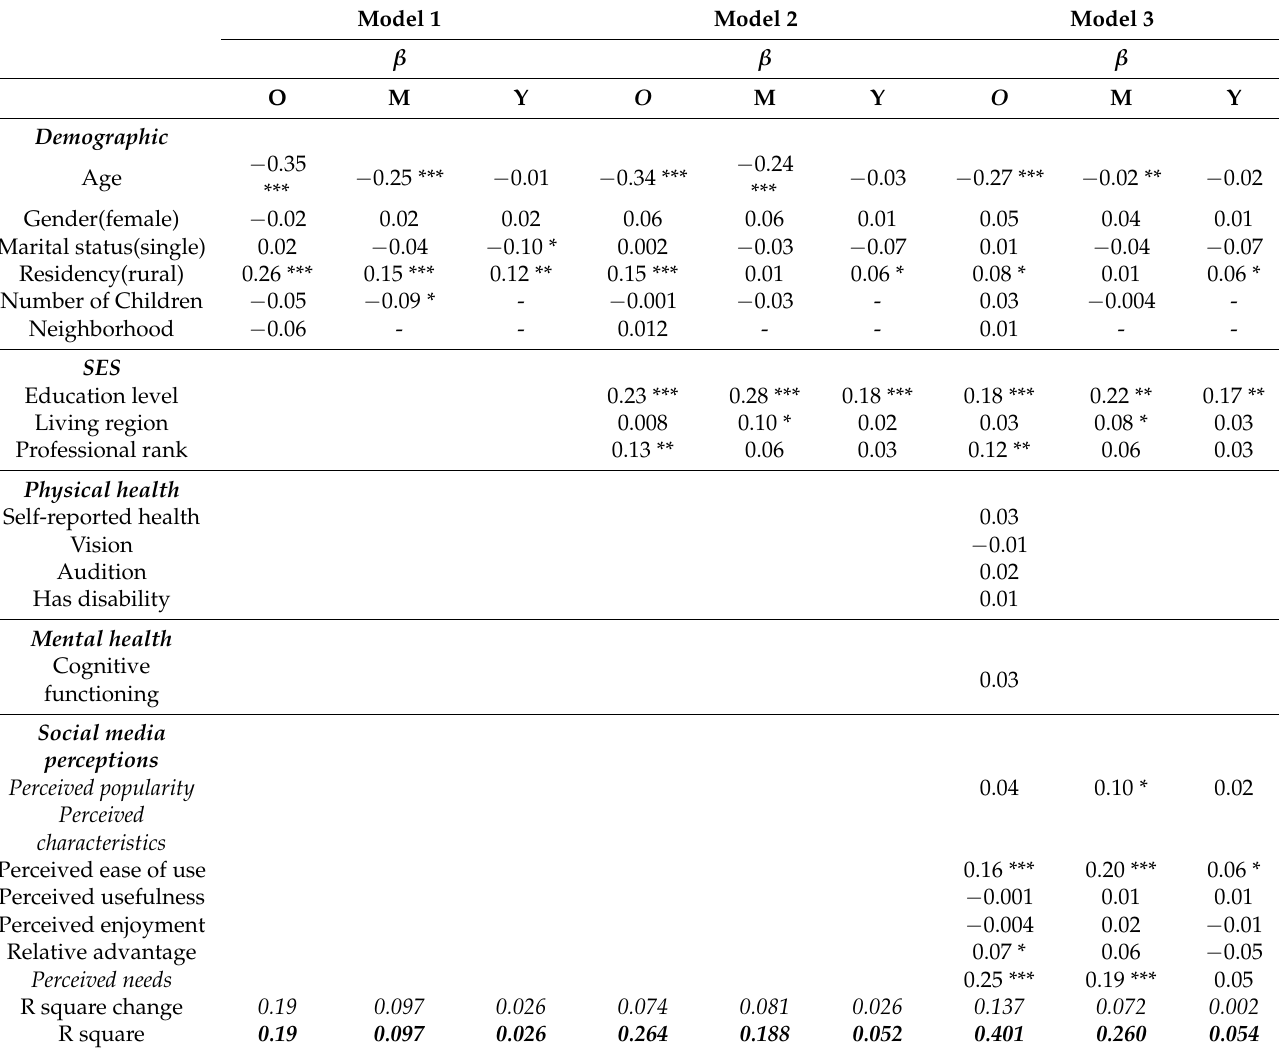
Table 3. Hierarchical linear regression analysis of the diversity of social media engagement. Model 1 Model